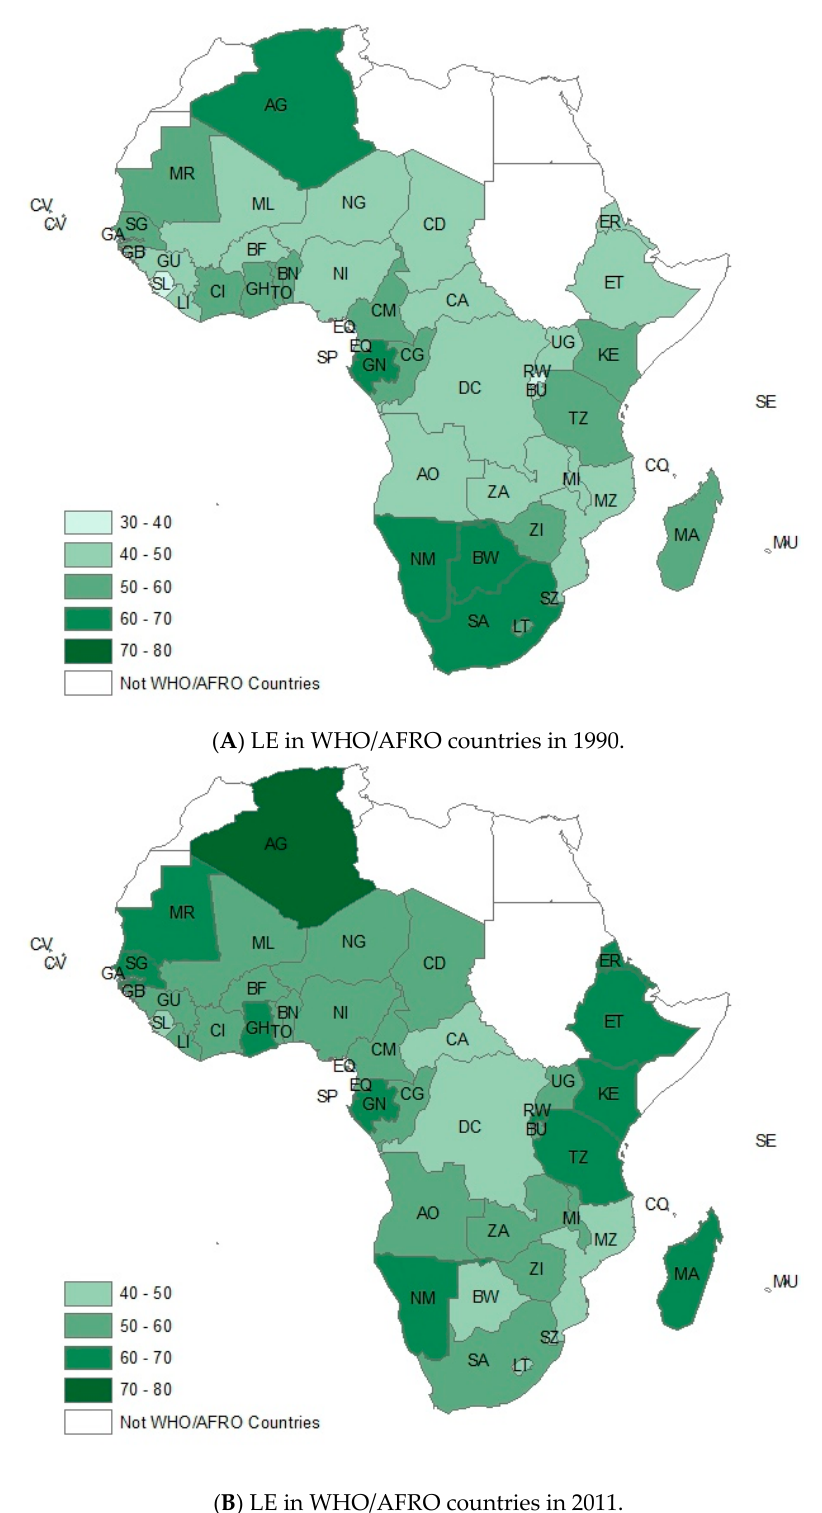
Figure 6. Comparing the variation of LE of Africa Countries, ( A ) 1990 and ( B ) 2011, by GIS. This figure showed the variation of LE by GIS.